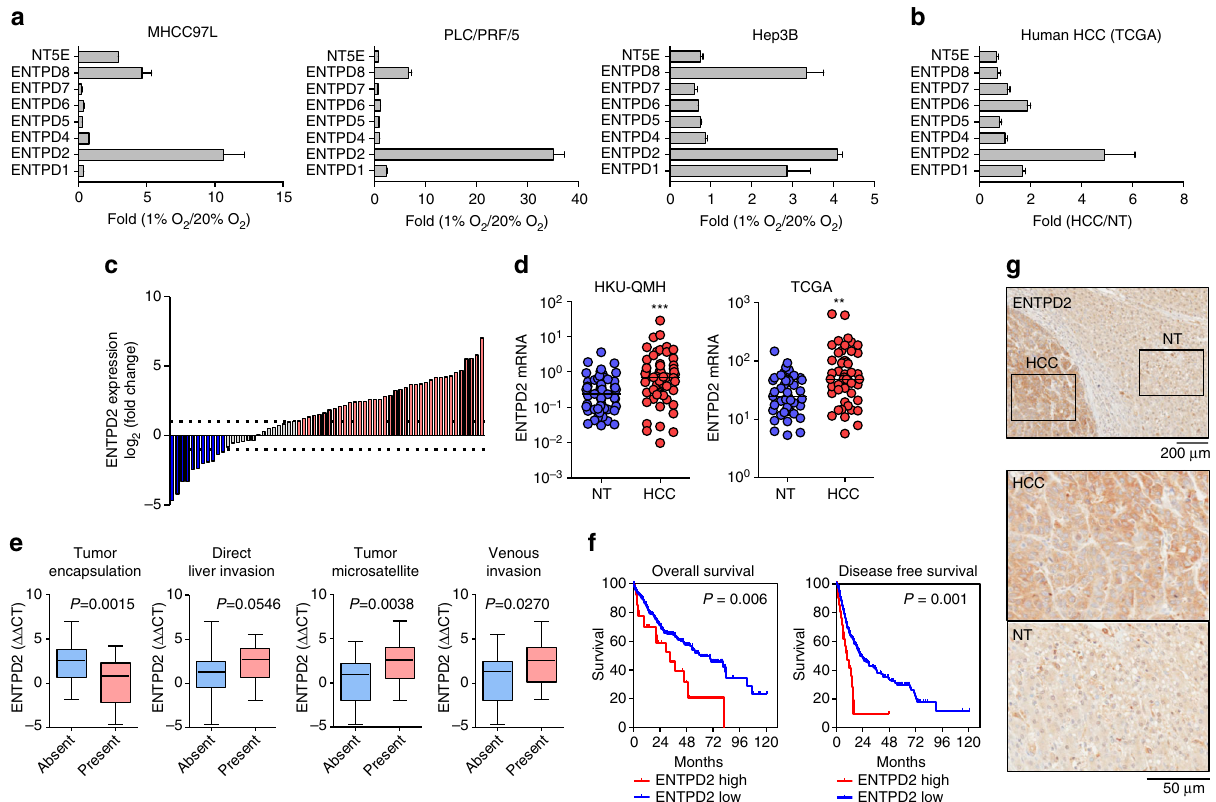
Fig. 1 ENTPD2 expression in HCC. a Real-time quantitative PCR analysis revealed the expression of ENTPD family members and NT5E in three HCC cell lines, MHCC97L, PLC/PRF/5, and Hep3B, exposed to 20 and 1% O 2 . Gene expression level was normalized to 20% O 2 ( n = 3). b TCGA database revealed the expression of ENTPD family members and NT5E in 49 cases of HCC tissues and their corresponding non-tumorous liver (NT) tissues. Gene expression level was normalized to NT. c Waterfall plot showed that ENTPD2 was overexpressed in 58% (36/62) of HCC patients. d Left : ENTPD2 mRNA expression in HCC tissues and their corresponding NT tissues from 62 patients = (Queen Mary Hospital (QMH), the University of Hong Kong (HKU)) was determined by qRT-PCR. Right : ENTPD2 mRNA expression in HCC and NT tissues in 49 HCC patients from the TCGC database. For qRT-PCR, values were normalized with house-keeping gene, HPRT . (Wilcoxon signed-rank test, ** P < 0.01, *** P < 0.001) e High expression of ENTPD2 was associated with aggressive associated with poorer overall and disease free survival in 368 and 347 HCC patients, respectively (log-rank test, P < 0.01). g Representative IHC